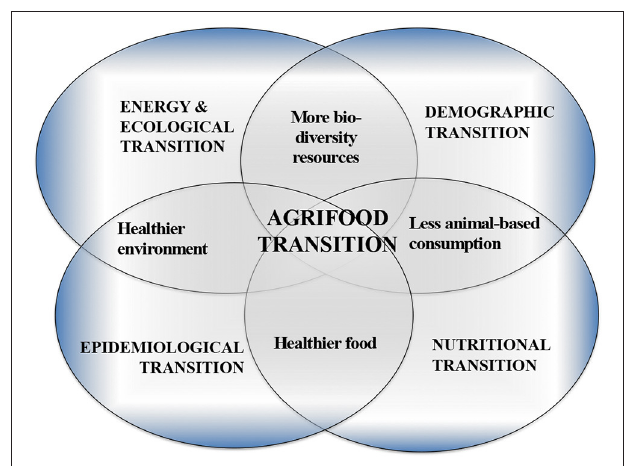
FIGURE 3 | Contemporary transition